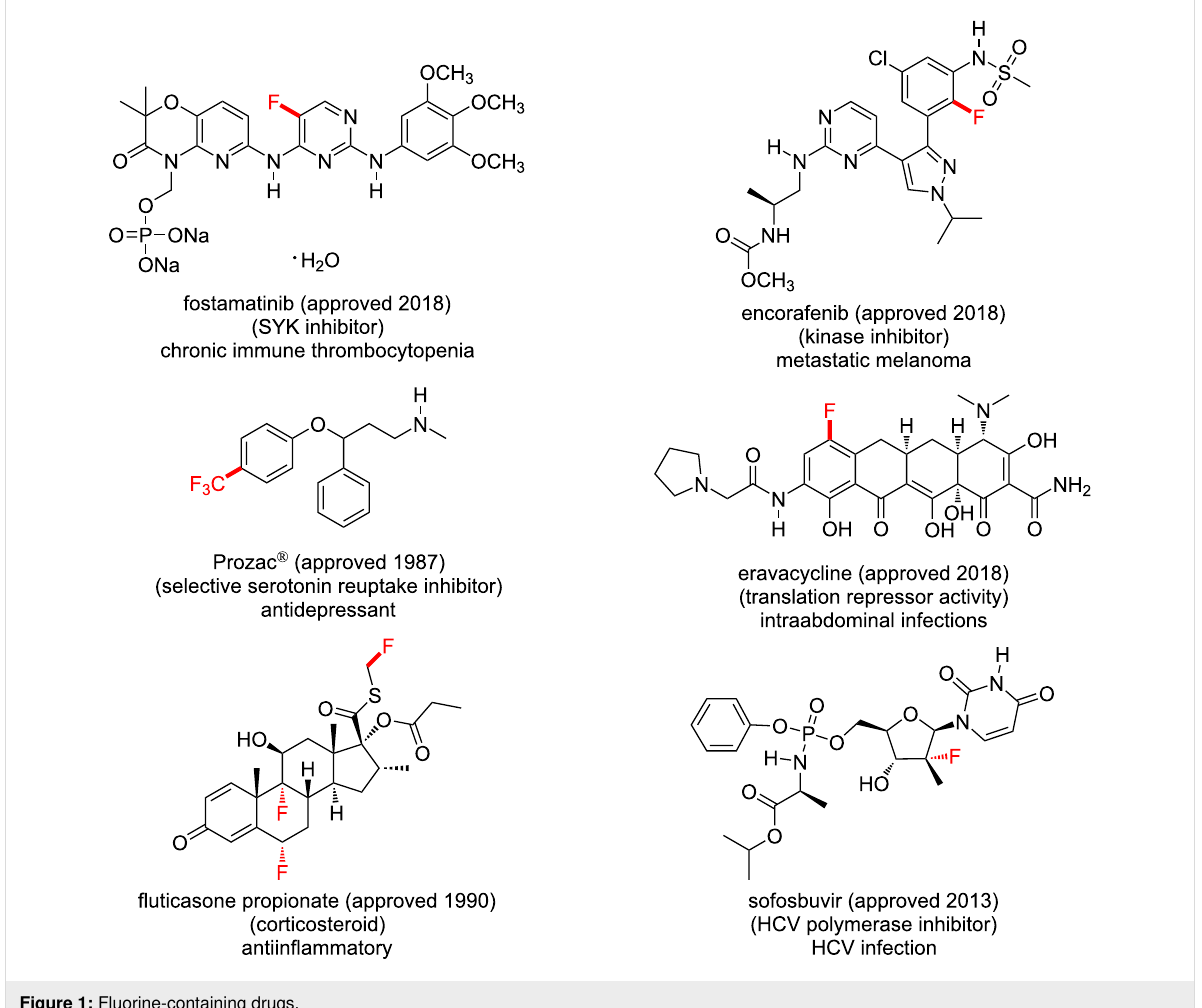
Figure 1: Fluorine-containing